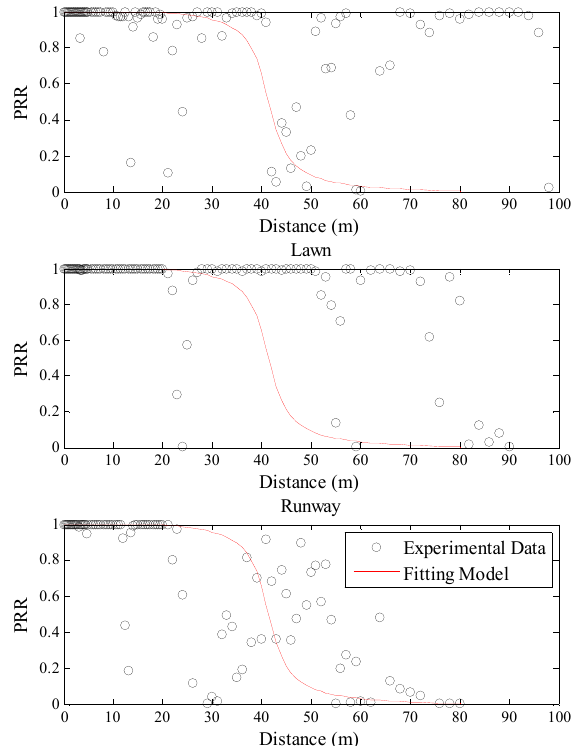
ff ects of the theoretical model in di ff erent environments. Figure 5. Effects of the theoretical model in different environments. Figure 5. E